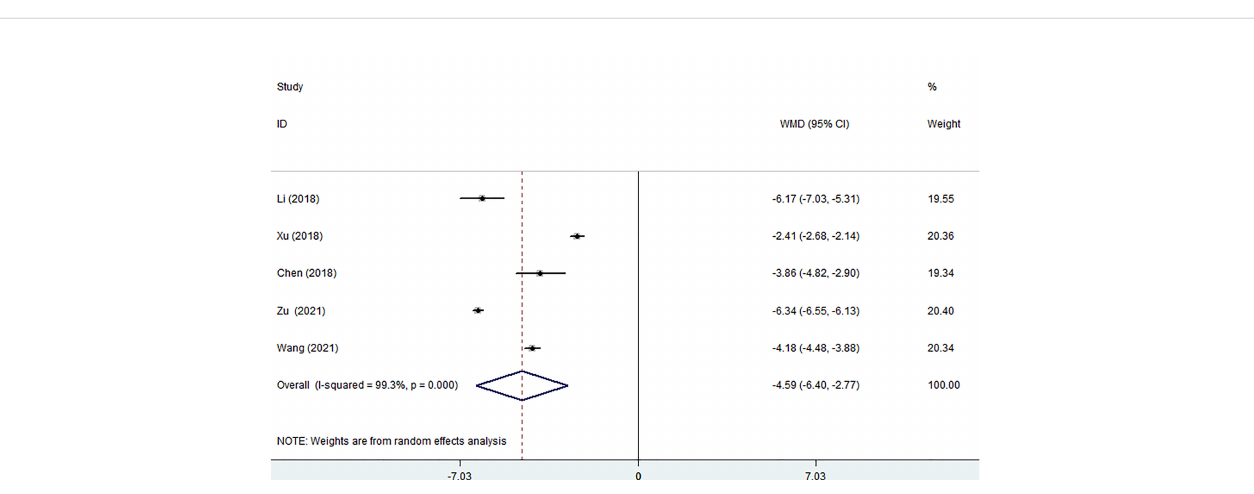
FIGURE 5 Forest plot of the hospital stay for comparing MWA with surgery in patient with PTMC. MWA, microwave ablation, PTMC, papillary thyroid